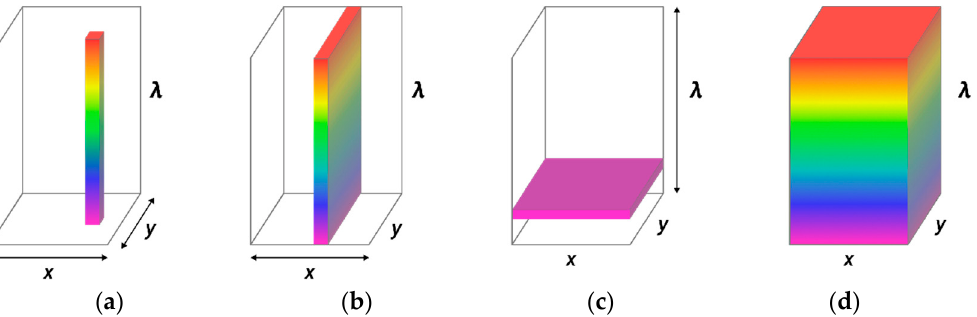
Figure 1. Three techniques used for building a hyperspectral image: ( a ) whiskbroom imager, ( b ) pushbroom imager, ( c ) staring imager, and ( d ) snapshot-type imagers.